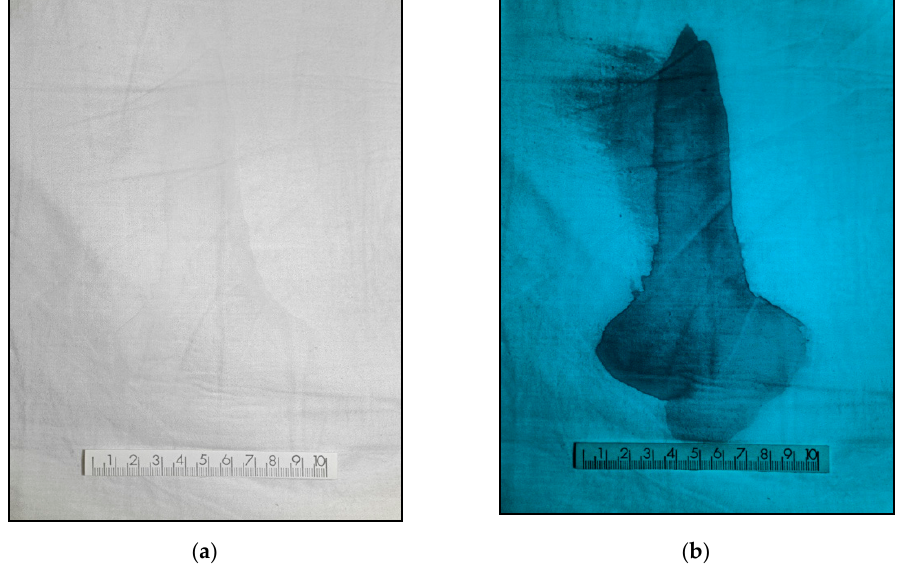
Figure 7. Images of a cotton sheet with traces of latent blood photographed: ( a ) with a conventional camera illuminated with white visible light and ( b ) Invespector system using UV illumination 365 nm.